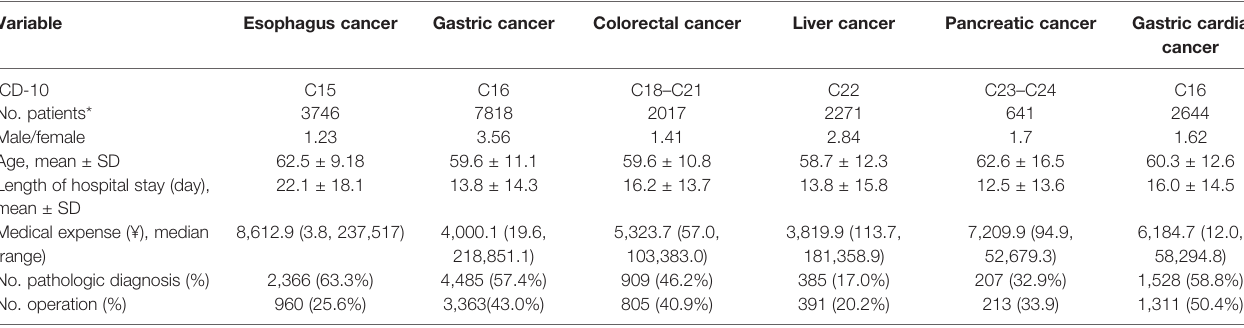
TABLE 1 | Epidemiologic features of GI neoplasms in Wuwei, northwestern China, 1995 – 2016.